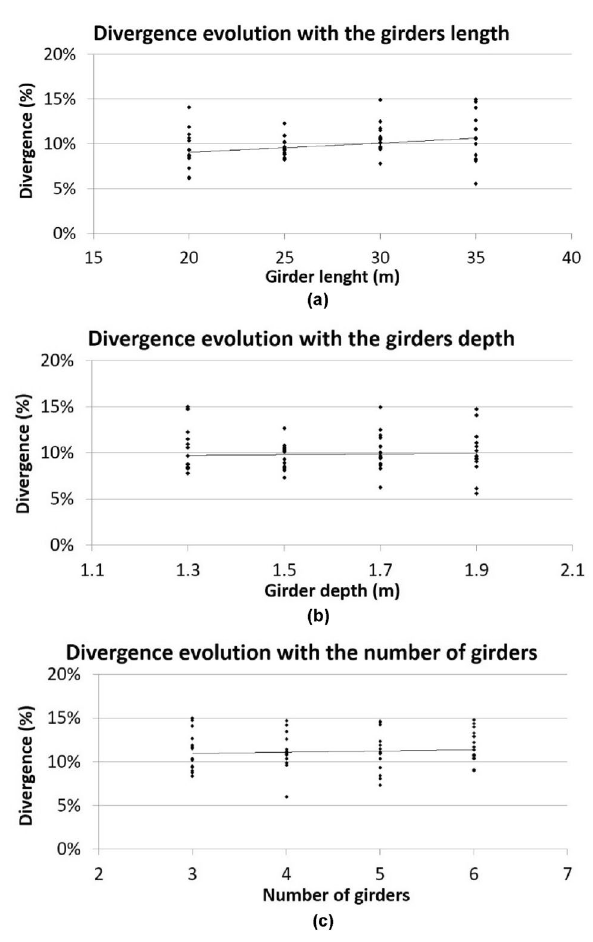
Figure 7. Divergence evolution with each of the analyzed variables: ( a ) girders length; ( b ) girders depth; ( c ) number of